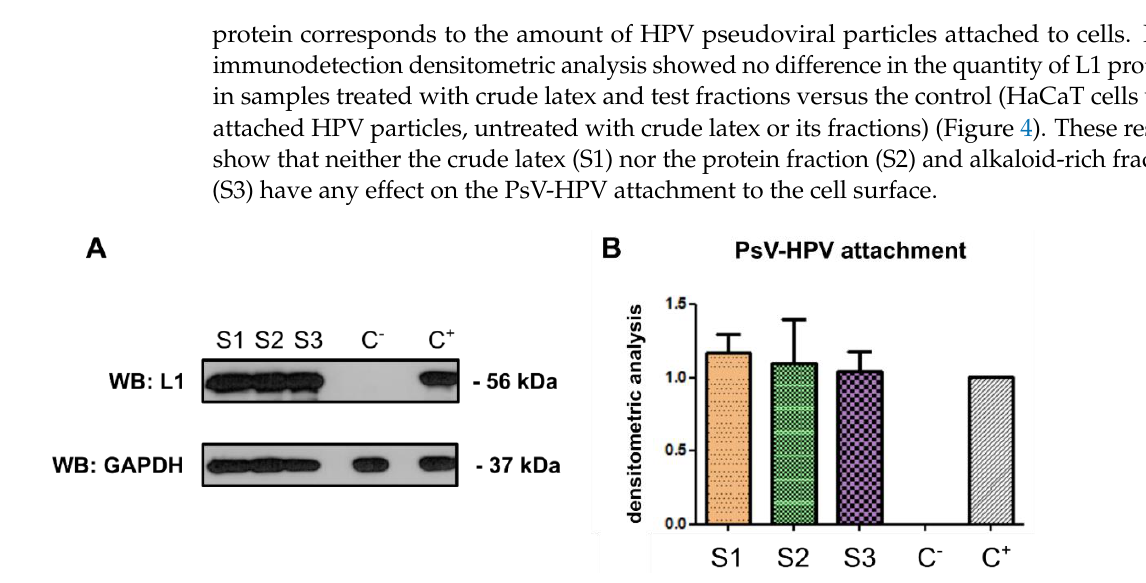
6 of 31 Figure 3. Effect of C. majus latex (S1), protein fraction (S2), and alkaloid-rich fraction (S3) on the stability of structural proteins L1 and L2 of the HPV capsid. HPV pseudovirions were treated with crude latex (S1) and its fractions (S2, S3), and incubated for 3 h. ( A ) Representative protein immu- nodetection result obtained by Western b lot using specific α - L1 and α -L2 antibodies. S1 — PsV-HPV particles treated with crude latex, S2 — PsV-HPV particles treated with the protein fraction, S3 — PsV- HPV particles treated with the alkaloid-rich fraction, Control — untreated PsV-HPV particles. After immunodetection, a similar amount of L1 and L2 proteins was observed for all tested samples, which proves that the crude C. majus latex, alkaloid-rich fraction, and protein fraction do not de- grade PsV-HPV capsid proteins. ( B ) Results of densitometric measurements of signals obtained on the film after immunodetection.